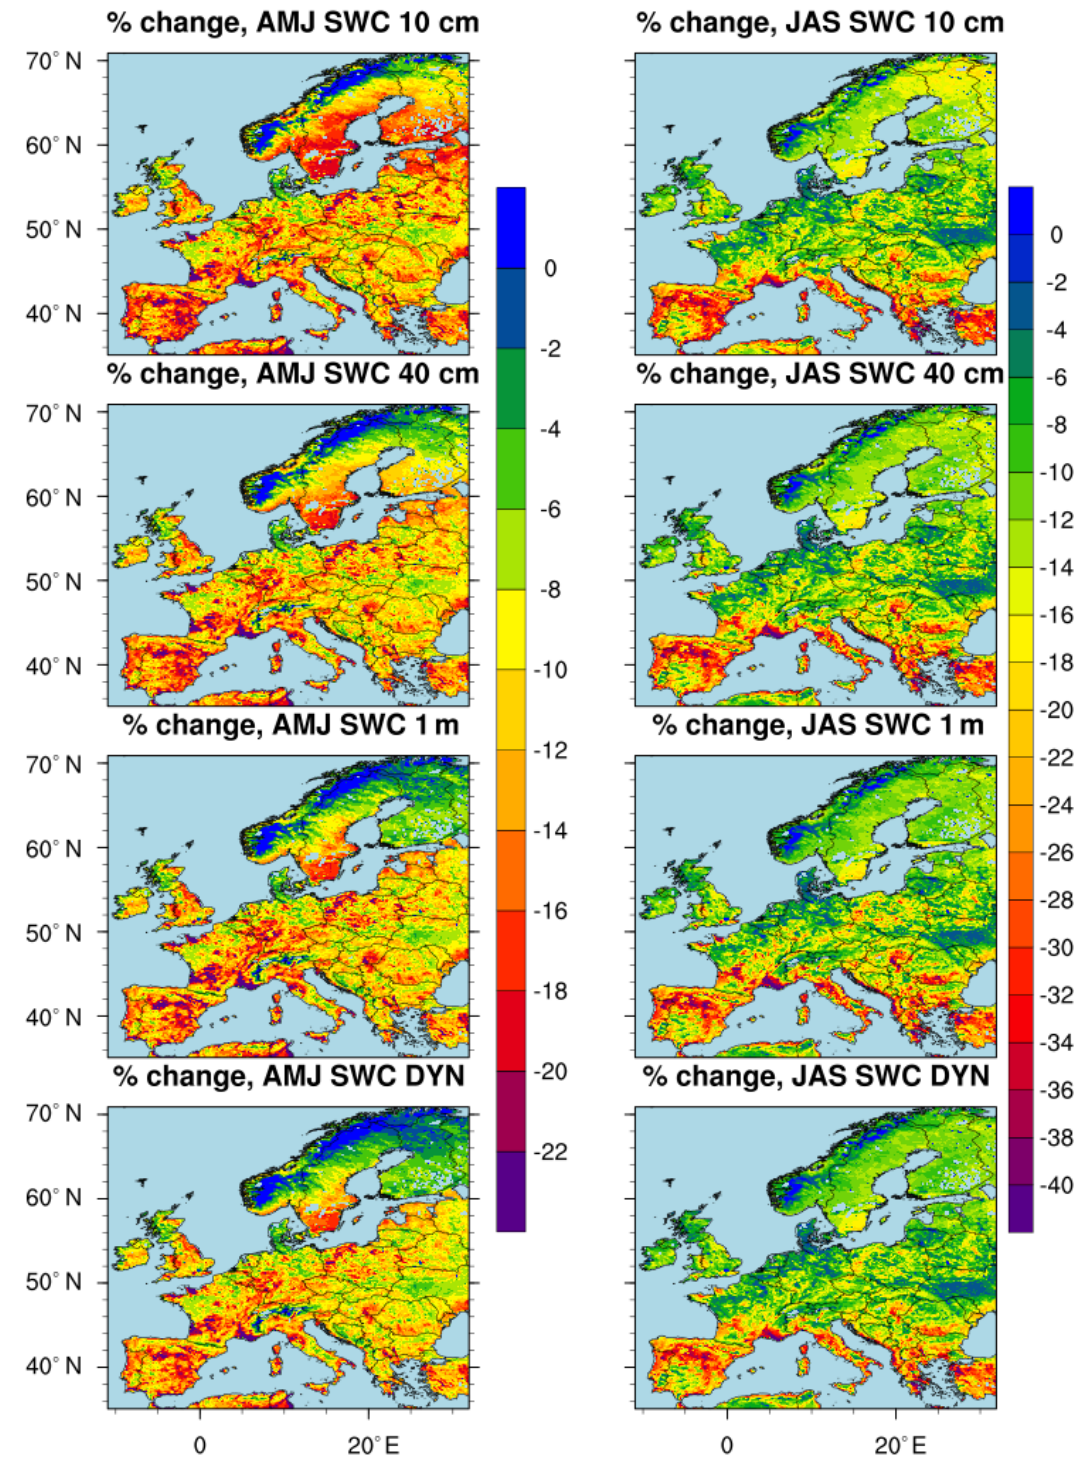
Figure 2. Percentage change in the amount of O 3 removed by dry deposition over the land points (sea points are masked) computed in the time periods April–May–June (AMJ) and July–August–September (JAS). The percentage change is defined as [(Sim–Ref) / Ref)] × 100, where Ref is the NO_SWC simulation and Sim represents the other simulations. A percentage change of 25% corresponds to about 6kg O 3 m − 2 d − 1